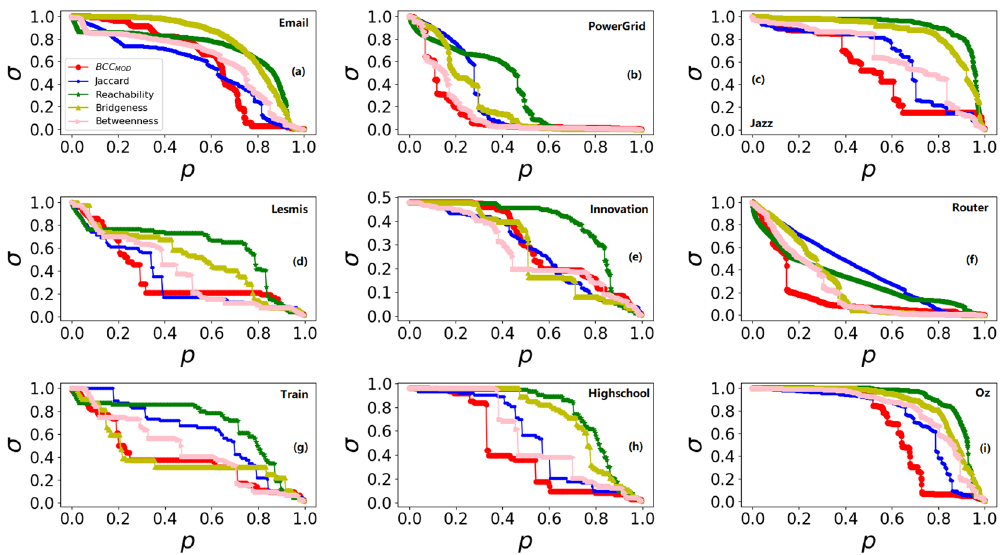
Figure 2. The size of giant component σ over different value of p .